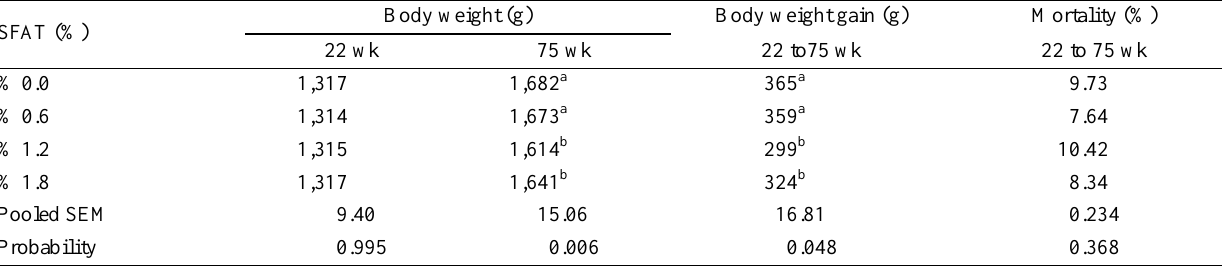
Table 3. Body weight, body weight gain and mortality of laying hens Body weight (g) Body weight gain (g) Mortality (%) SFAT (%) 22 wk 75